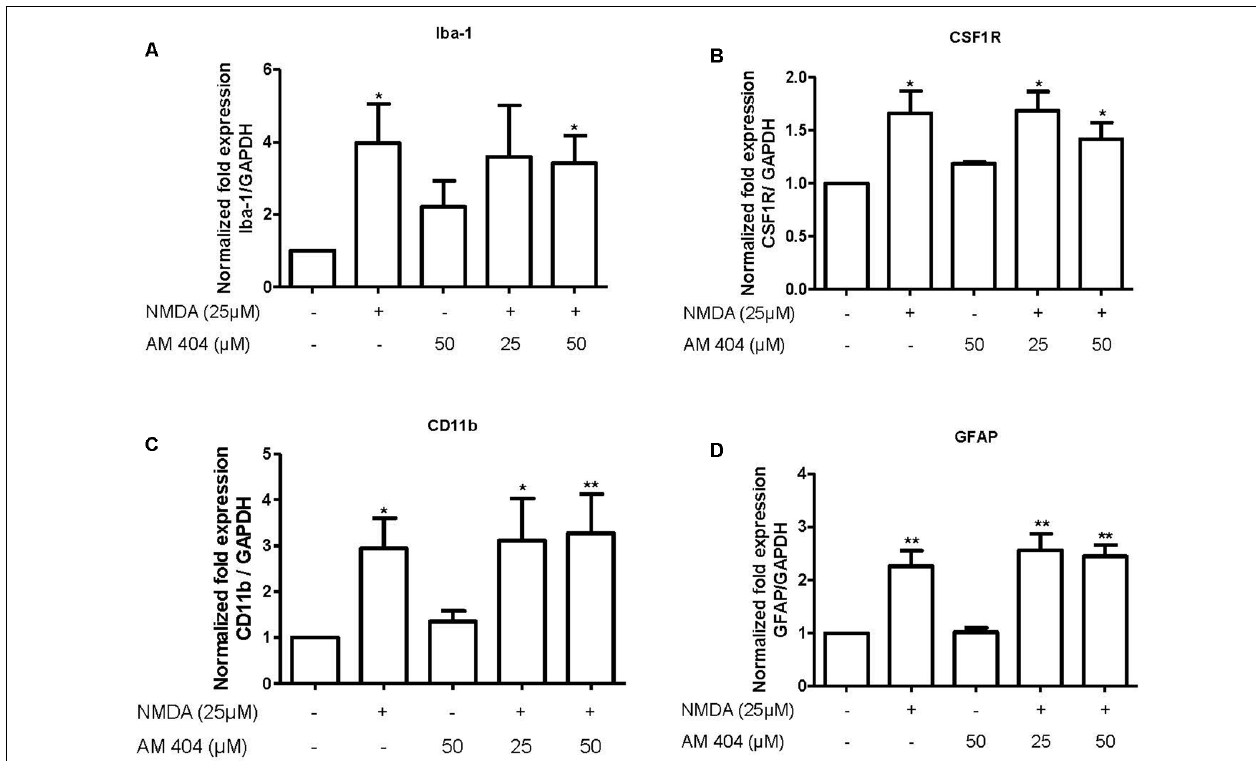
FIGURE 4 | Effect of AM404 on microglia and astrocyte after 25 µ M NMDA in OHSC. The OHSCs were pre-treated with two concentrations of AM404 (25 or 50 µ M) for 30 min before stimulating with 25 µ M NMDA. After 4 h, microglia markers, Iba-1 (A) , CSF1R (B) and CD11b (C) , an astrocyte marker, GFAP (D) were measured by qPCR. Data are expressed as mean ± SEM of at least three OHSCs/group. ∗ p < 0.05, ∗∗ p < 0.01 with respect to negative control (one-way ANOVA followed by the Newman–Keuls